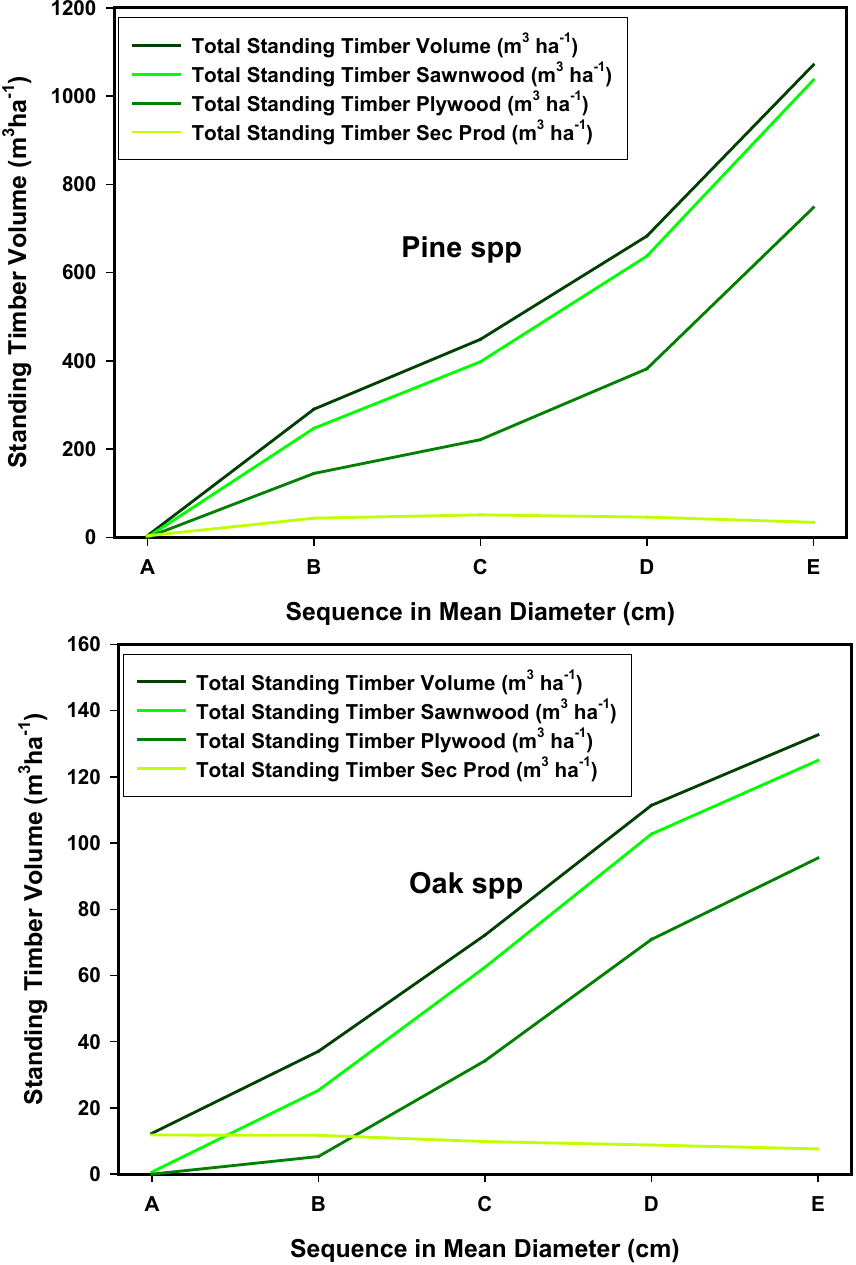
Figure 7. Graphical representation of the standing timber volume classified in merchantable forest products (sawnwood, plywood and secondary forest products) for pine and oak species of northern temperate forests of Mexico. Note capital letters indicate the sequence in mean quadratic